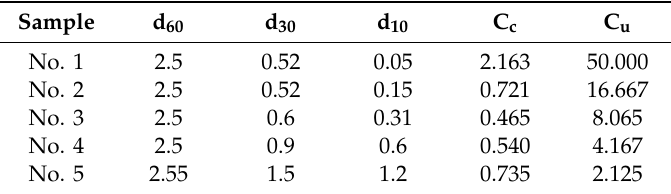
Table 2. Gradation parameters of the samples.